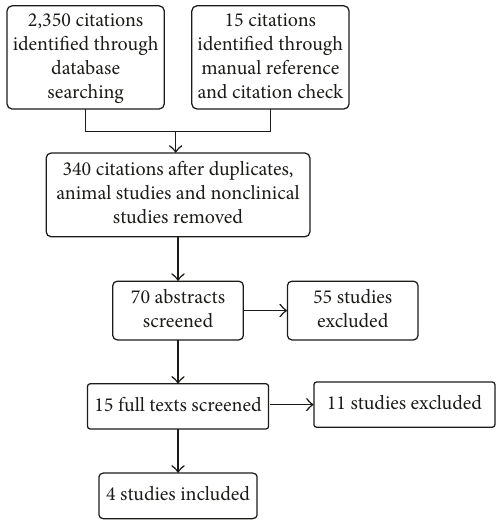
Figure 1: Study flow Table 1: Study characteristics.